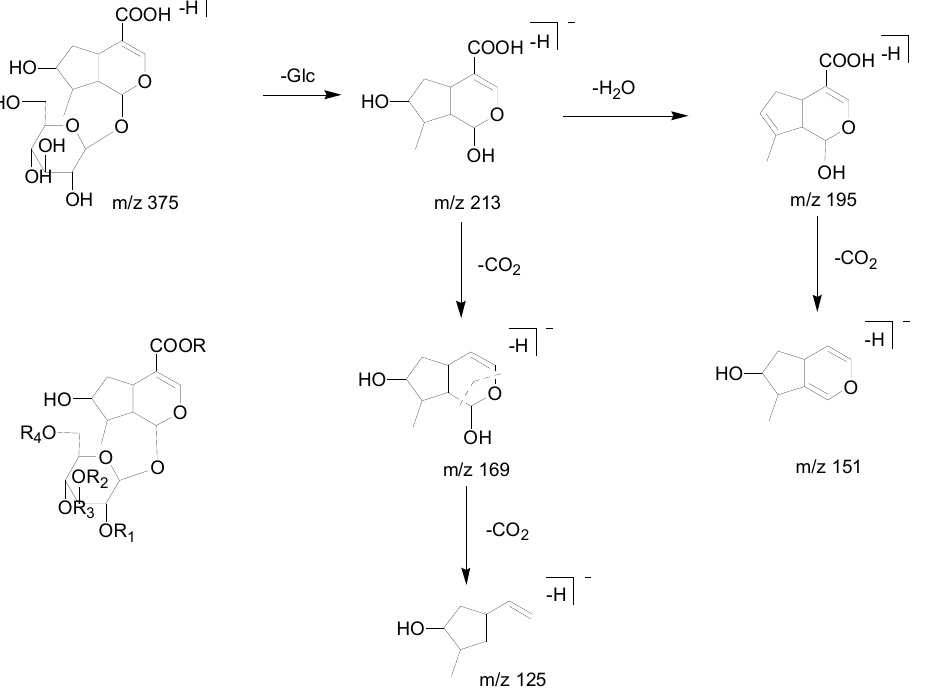
Figure 4. The proposed fragmentation pathway of loganic acid.